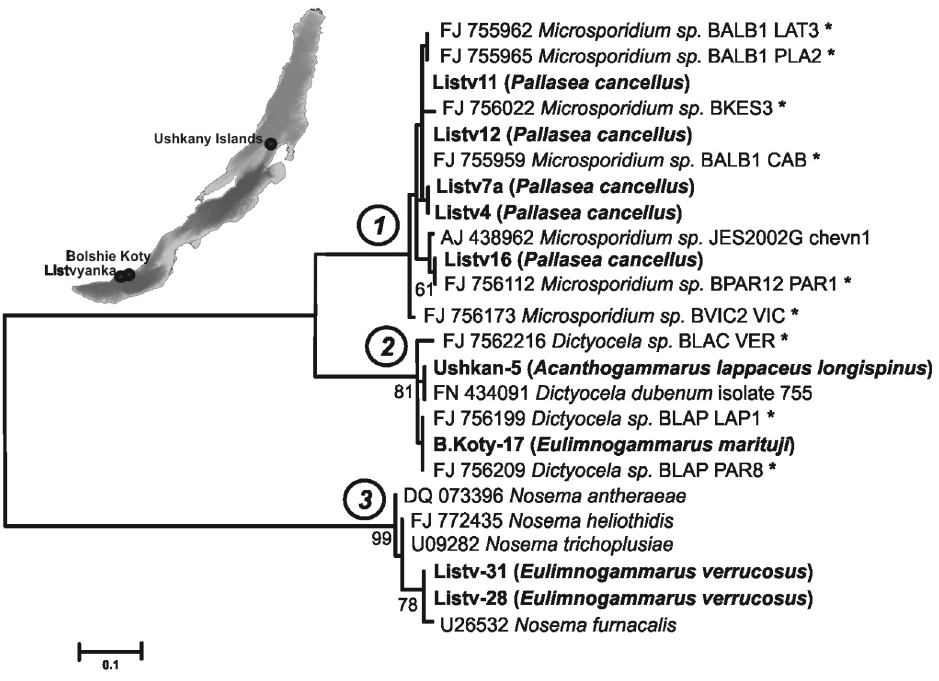
Fig 1. Maximum likelihood phylogenetic tree of Microsporidia. Bootstrap values ( > 50%) are presented for nodes and branch lengths are drawn to scale. The species of microsporidia noted with ‘ * ’ found in Baikalian endemic amphipods (GenBank data).